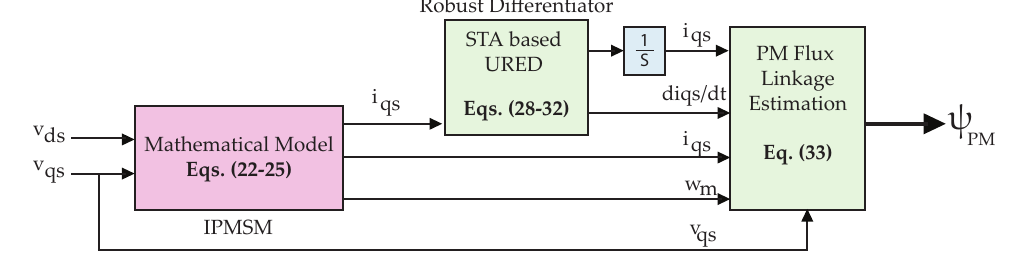
Figure 4. Block diagram of STA based URED for IPM flux linkage